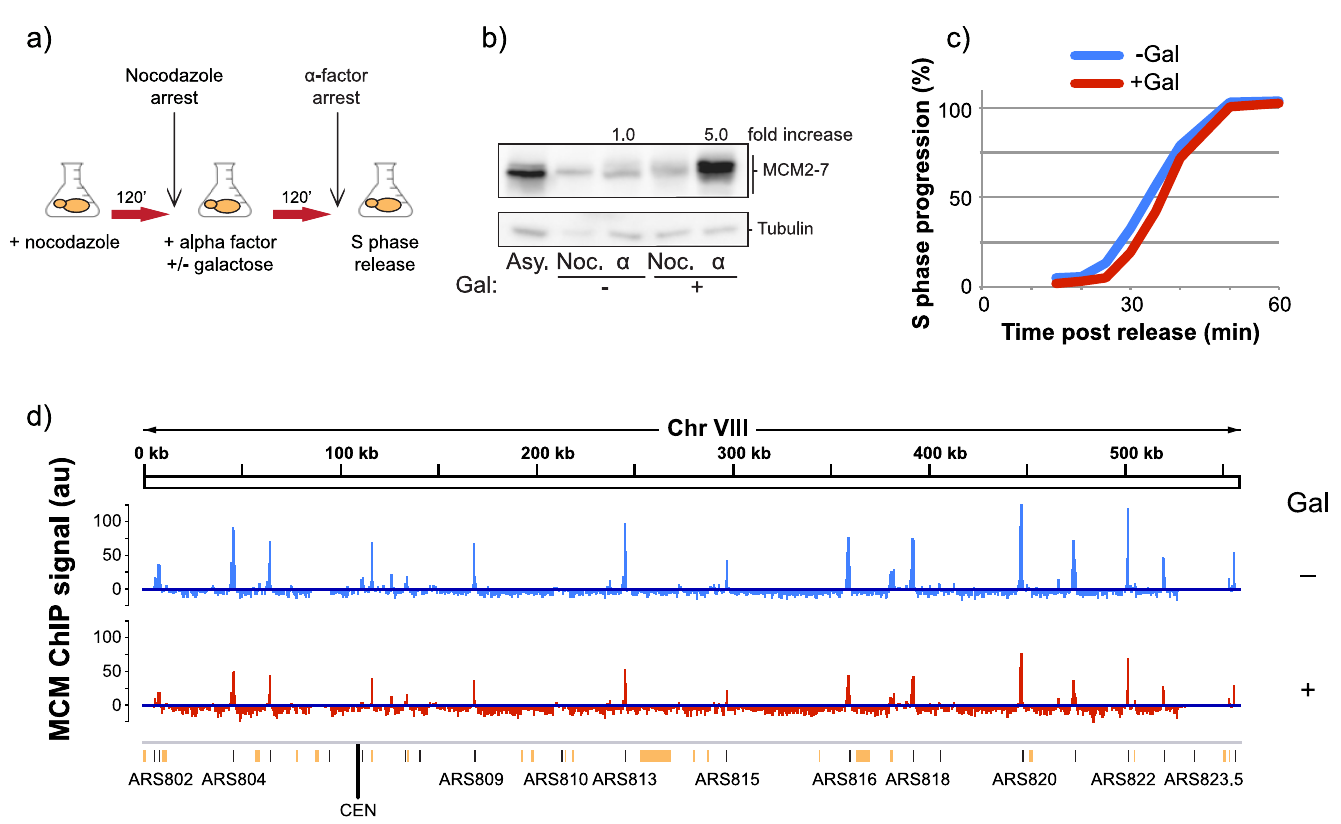
Fig 5. Galactose-induced MCM overexpression. a) Experimental outline for MCM overexpression experiments. yFS1075 cells were first synchronized with nocodazole, then released into α -factor for a G1/S arrest, prior to release into S phase. Flask symbol indicates filtering and release into new media, with or without galactose and additives as indicated. b) Western blot of yFS1075 cells showing the levels of MCM at the indicated time points of the experiment, probed using anti- Mcm2-7 polyclonal antibody UM174. Noc = nocodazole arrest, α = α factor arrest. Boxed values indicate quantitation of Mcm2-7 levels in α -factor arrested cells with or without galactose induction, relative to Mcm2-7 levels of uninduced cells. c) Quantitation of flow cytometry data of the replicating population of yFS1075 cells as they progress from α -factor arrest through S phase. d) Normalized MNase-ChIP-seq coverage on Chromosome VIII at the α factor arrest point in 1 kb bins. ARS-annotated origins of replication are shown as black lines whereas unconfirmed origins are shown as orange